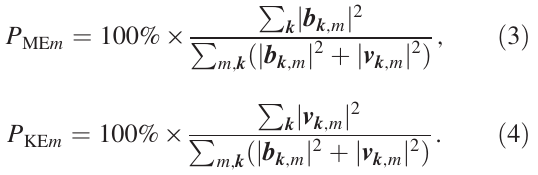
FIG. 2. The time-averaged fractions of mode energies in different modes in different simulations. Each simulation has two bars. The left one represents the velocity field showing the three mode percentages ( P , P , and P in blue, green, KEA KES KEF and red, respectively). Similarly, the right bar is for the magnetic field showing P , P , and P in their respective colors. MEA MES MEF Both the bars add up to 100%. Compressive driving leads to a significantly larger fraction of the fast magnetosonic